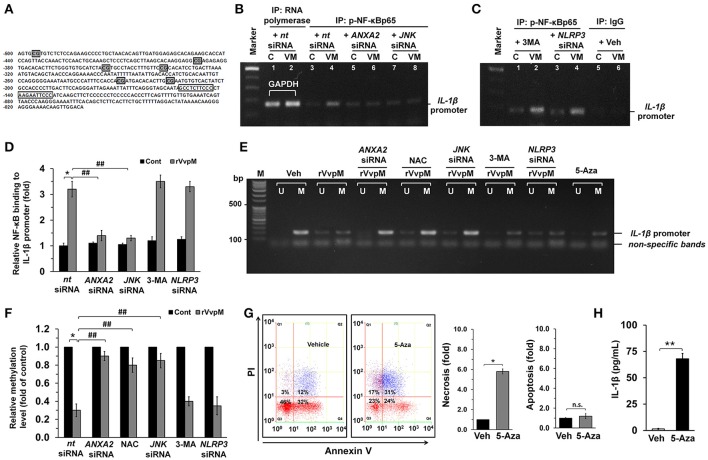
Regulatory effect of VvpM on the interaction of NF-κB with the IL-1β promoter. (A) The NF-κB binding sites and methylation site in the IL-1β promoter are shown. The open boxes and shaded box represent the consensus sequences of NF-κB and the methylation site, respectively. (B,C) Cells were transfected with siRNAs for ANXA2, JNK, and NLRP3 for 24 h or pre-treated with 3-MA (10 mM) for 30 min prior to rVvpM exposure for 60 min. Cells were then fixed with formaldehyde, and cell extracts were immunoprecipitated (IP) with anti-p-NF-κBp65 to detect bound IL-1β promoter DNA fragments. A representative agarose gel following RT-PCR is shown. n = 3. Normal mouse IgG or anti-RNA polymerase II antibody was used as negative or positive control for the ChIP, respectively. C, control. VM, rVvpM. (D) The level of p-NF-κBp65 binding to IL-1β promoter was quantified by qRT-PCR. Anti-RNA polymerase II antibody was used internal control. n = 3. (E) Genomic DNA of the cells transfected with siRNAs for ANXA2, JNK, and NLRP3 for 24 h or pre-treated with NAC (10 μM), 3-MA (10 mM), and 5-aza (1 μM) for 30 min prior to rVvpM exposure for 60 min was prepared. Changes in the IL-1β promoter methylation status were determined by MSP analysis. U, unmethylated form. M, methylated form. (F) The level of IL-1β methylation was quantified by qRT-PCR. Relative level of IL-1β methylation is shown, compared to the unmethylated form. n = 4. (G) Cell were treated with 5-aza (1 μM) for 24 h. FACS analysis (left panel) and quantitative analysis of the fold changes of necrotic (Q1) and apoptotic (Q2+Q4) cells by FACS analysis is shown (right panel). n = 4. (H) The level of IL-1β protein was quantified by ELISA. n = 5. (D,F)
*P < 0.01 vs. nt siRNA + Veh (boiled rVvpM). ##P < 0.01 vs. nt siRNA + rVvpM. (G,H)
*P < 0.01 and **P < 0.001 vs. cells with no treatment, respectively.